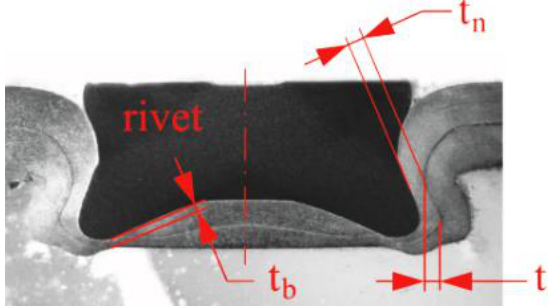
Figure 17. The CR joint parameters. Table 4. CR joint interlock